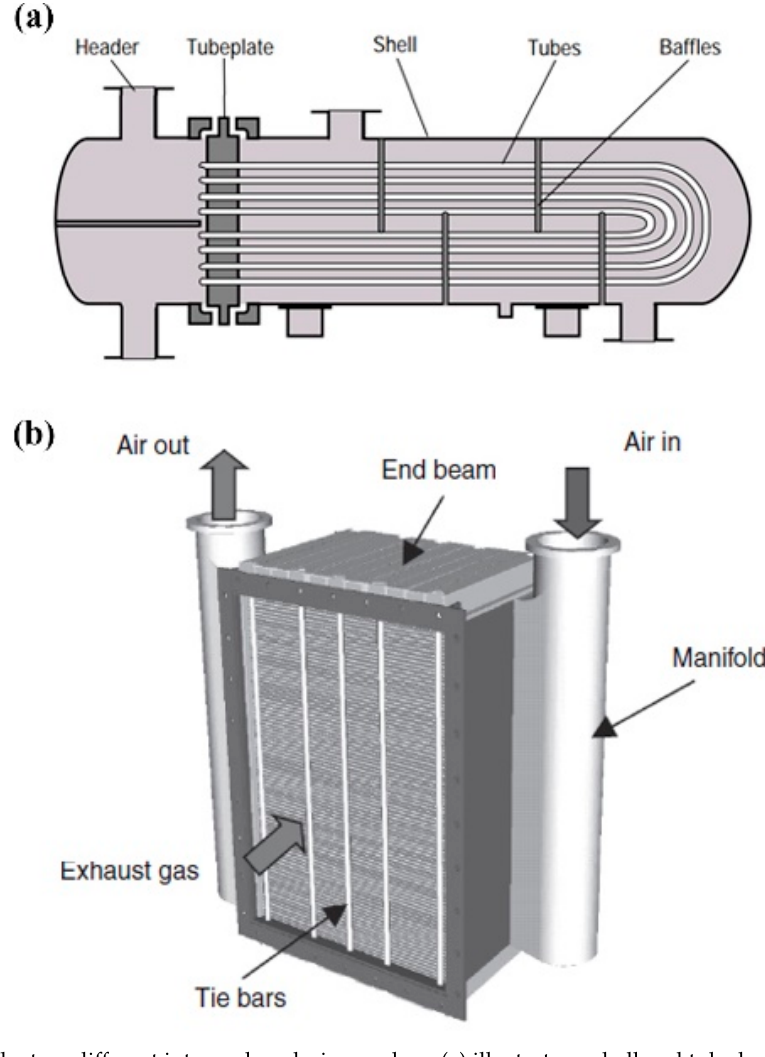
Figure 4. The two different intercoolers designs, where ( a ) illustrates a shell and tube heat exchanger, and ( b ) shows the tube-fin heat exchanger design [22].